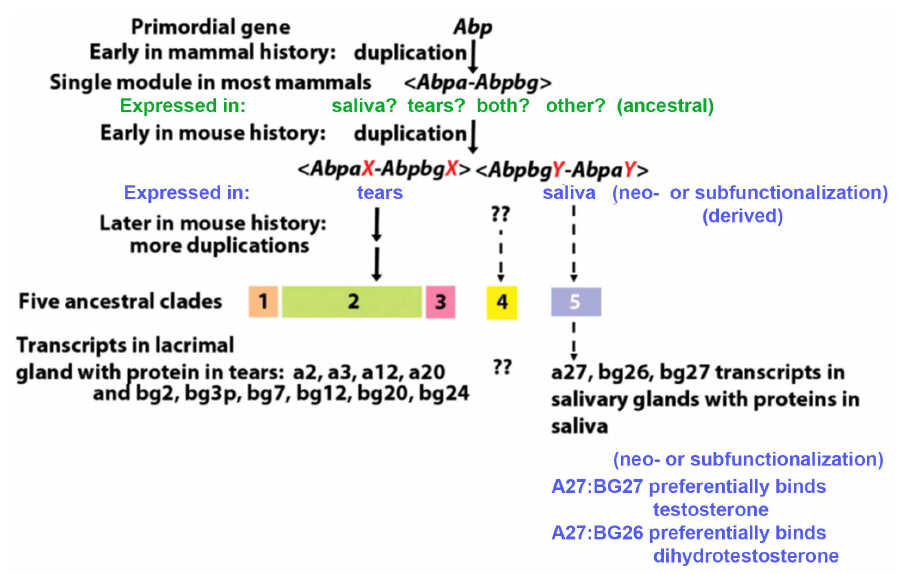
Fig. 4. A model for the evolution of Abp paralog expression differences in lacrimal gland/tears and salivary gland/saliva. The steps in this evolution are described in the